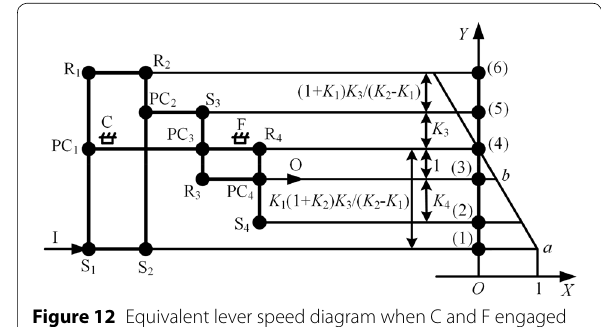
Figure 12 Equivalent lever speed diagram when C and F